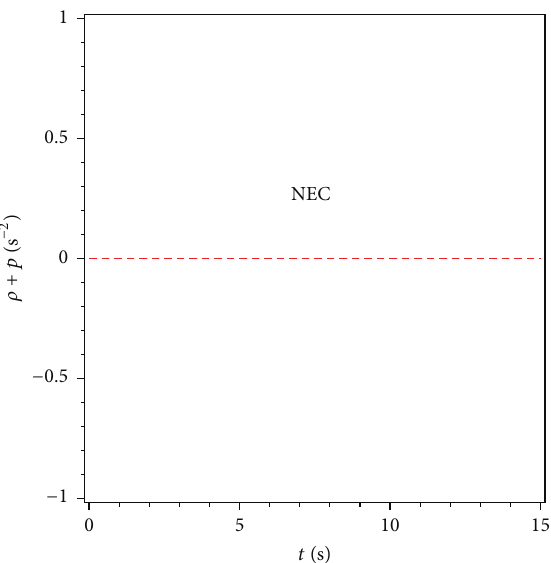
Figure 1: The evolution of NEC for closed model. Here the sign of the four constants 𝑐 󸀠 1 , 𝑐 󸀠 2 , 𝑐 󸀠 3 , and 𝑐 󸀠 4 has no effect on the evolution of NEC.